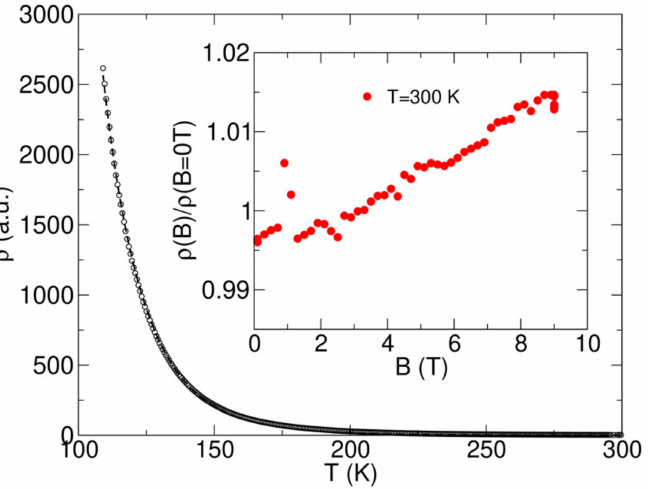
Figure 11. The resistivity of the Zn 0.88 Pb 0.12 Cr 2 Se 4 single crystal measured vs. temperature (central Figure) and vs. field at T = 300 K (inset). The Zn 0.88 Pb 0.12 Cr 2 Se 4 sample was tiny. Hence, we do not provide the absolute value of the